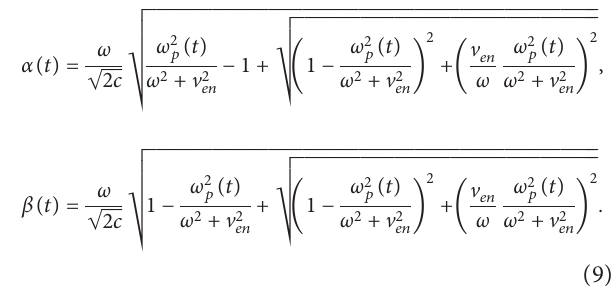
w � 0 . 7; (b) w w � 0 . 8; (c) w w � 0 . p / p / p /